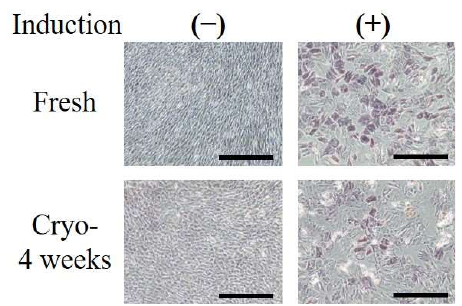
Figure 3. Osteogenic differentiation in ASCs. Fresh or Cryo-ASCs were differentiated into osteoblasts (as described in the Materials and Methods section). Osteogenesis was revealed by alkaline phosphatase staining. (−): confluent state without osteogenic induction; (+): 21 days after osteogenic induction. Scale bars = 500 µm.